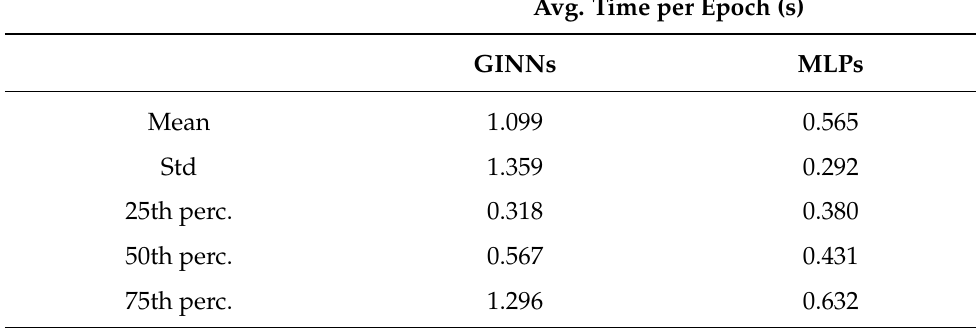
Table 3. Global statistics of the average training time per epoch for GINN and MLP models, expressed in seconds.